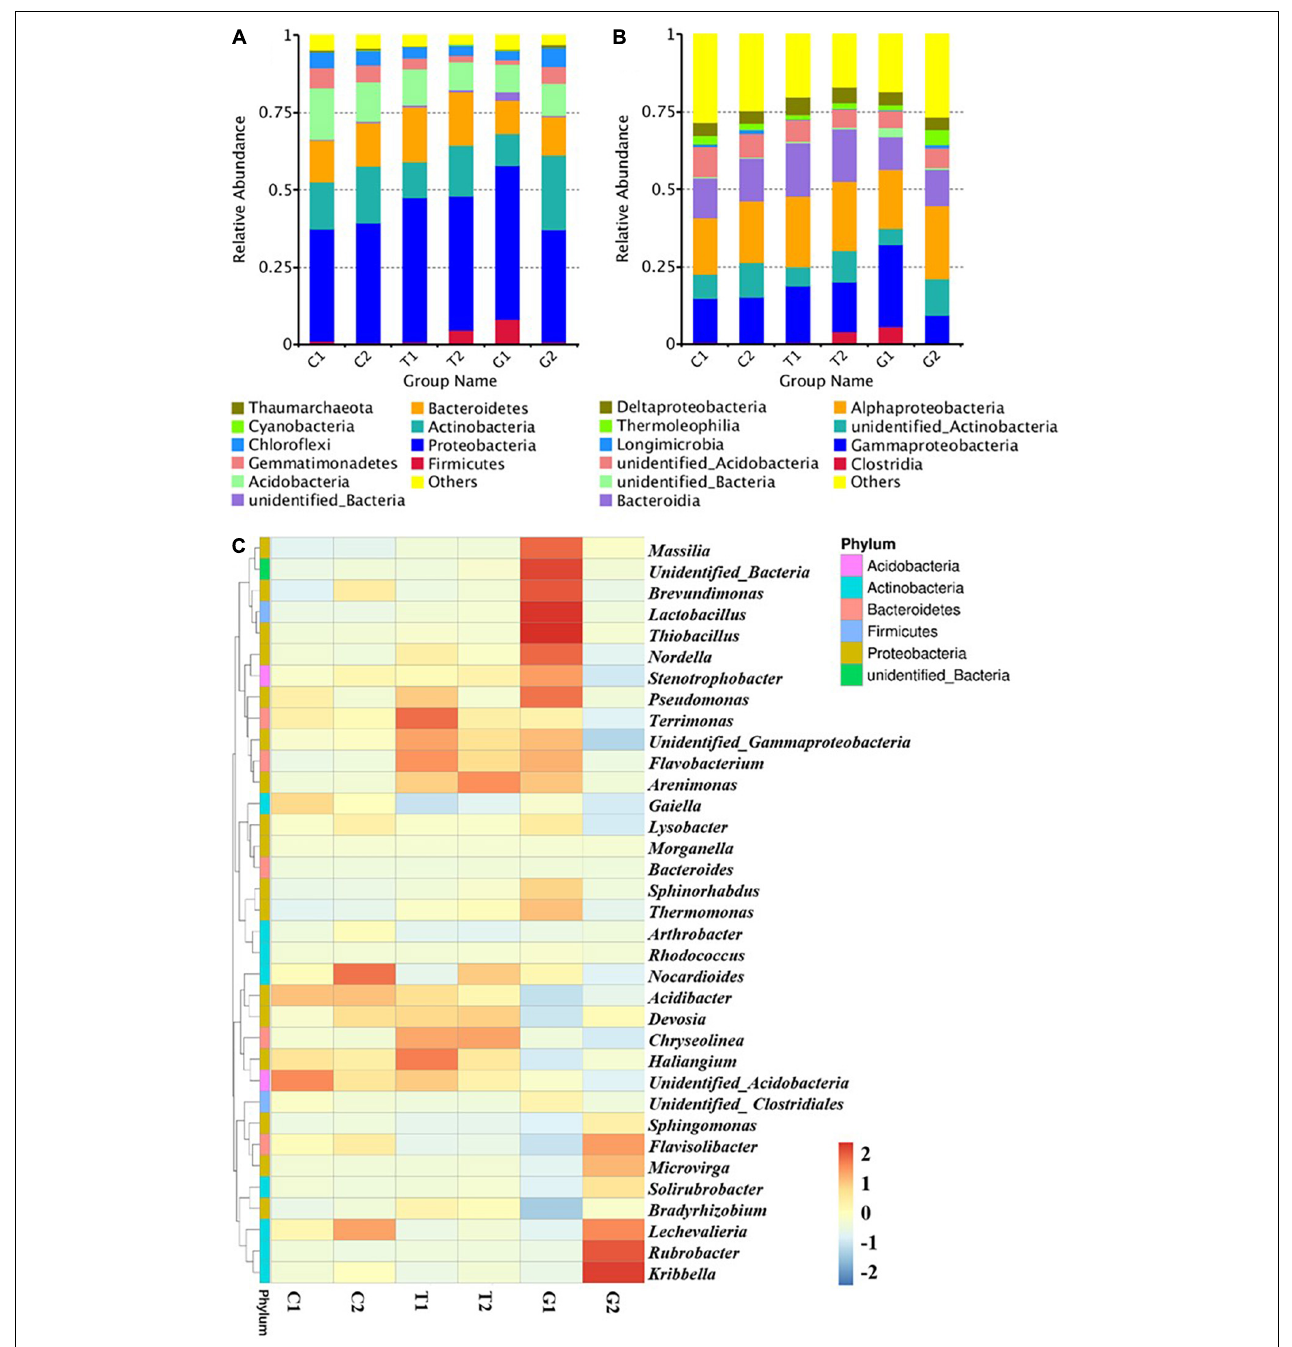
FIGURE 4 | Microbial community composition at different levels: (A) phylum, (B) class, and (C) classified genus (top 35). C1: cultivated land with distance to river from 100 to 200 m; C2: cultivated land with distance to river from 300 to 500 m; G1: grassland with distance to river from 100 to 200 m; G2: grassland with distance to river from 300 to 500 m; T1: forestland with distance to river from 100 to 200 m; T2: forestland with distance to river from 300 to 500